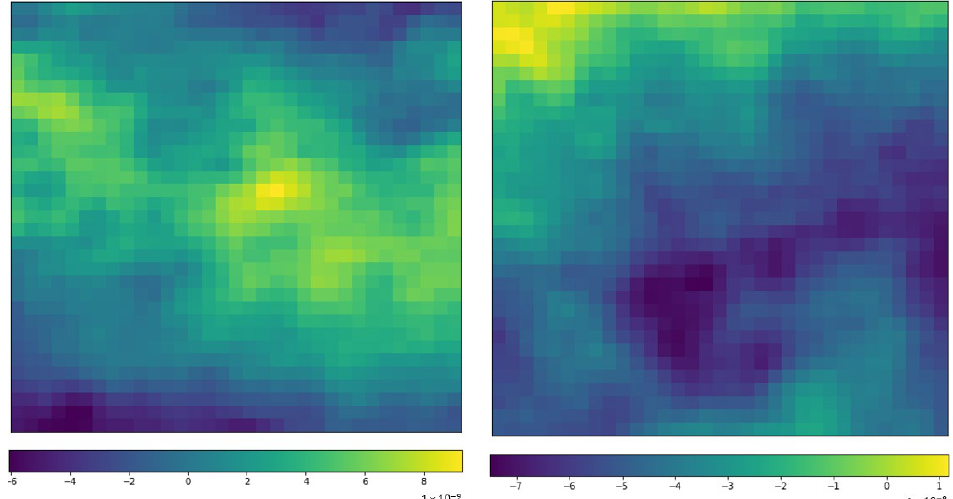
Figure 13. Distribution of mean Ozone mass mixing ratio (o3) differences (unit: kg/kg) between the 584 RI cases and randomly selected 584 non-RI samples at (in order of left -to- right and top -to- bottom ) 100 hPa, 200 hPa, 300 hPa, 500 hPa, 800 hPa, and 1000 hPa, respectively. The X-axis and Y-axis are aligned as in Figure